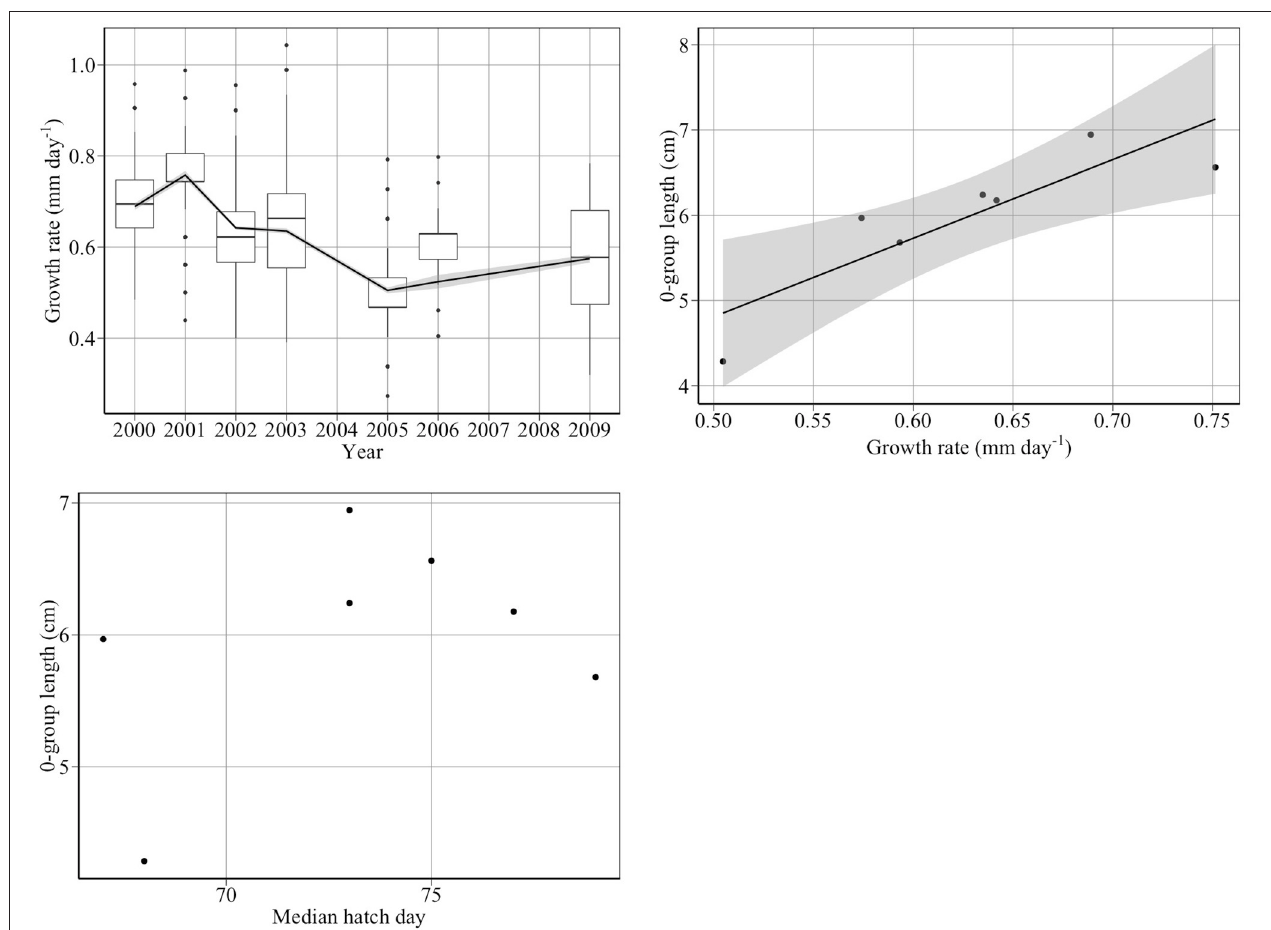
FIGURE 7 | Drivers of changes in 0-group length between 2000 and 2009. The top left panel shows year-to-year changes in juvenile growth rate (mm day − 1 ). The top right panel shows that changes in juvenile growth rate ( g l ) are significantly related to changes in 0-group length ( L ) (adjusted R 2 : 0.71, p < 0.02) ( L = 0.198 + 9.22* g l ). The bottom left panel shows that changes in median hatch date did not account for changes in 0-group